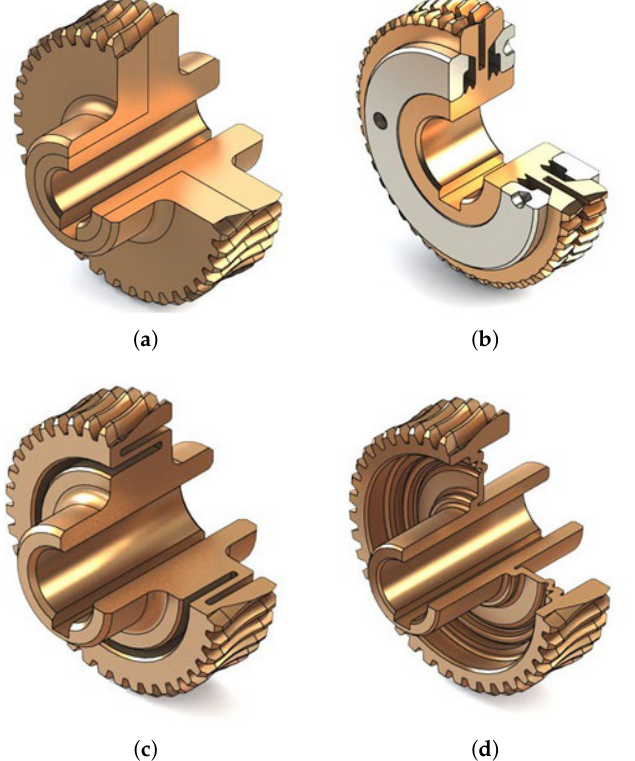
Figure 10. Examples of worm wheels with modified design. ( a ) Symmetrically split worm wheel. ( b ) Worm wheel with a rim split with circumferential cut-out. ( c ) Adaptive worm wheel with circumferential narrowing. ( d ) Adaptive worm wheel with connecting